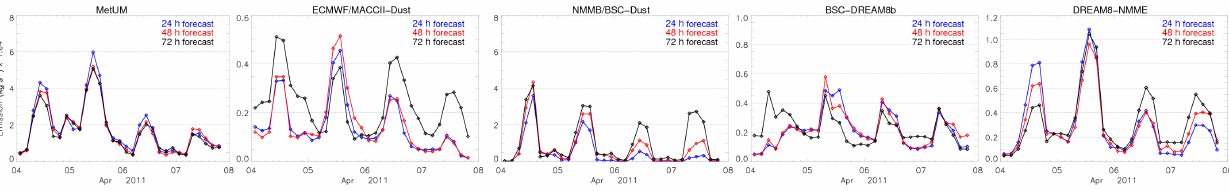
Figure 6. Time series of 3-hourly emissions from models MetUM TM , ECMWF/MACC, NMMB/BSC-Dust, BSC-DREAM8b and DREAM8-NMME with 24, 48 and 72h lead time (blue, red and black,